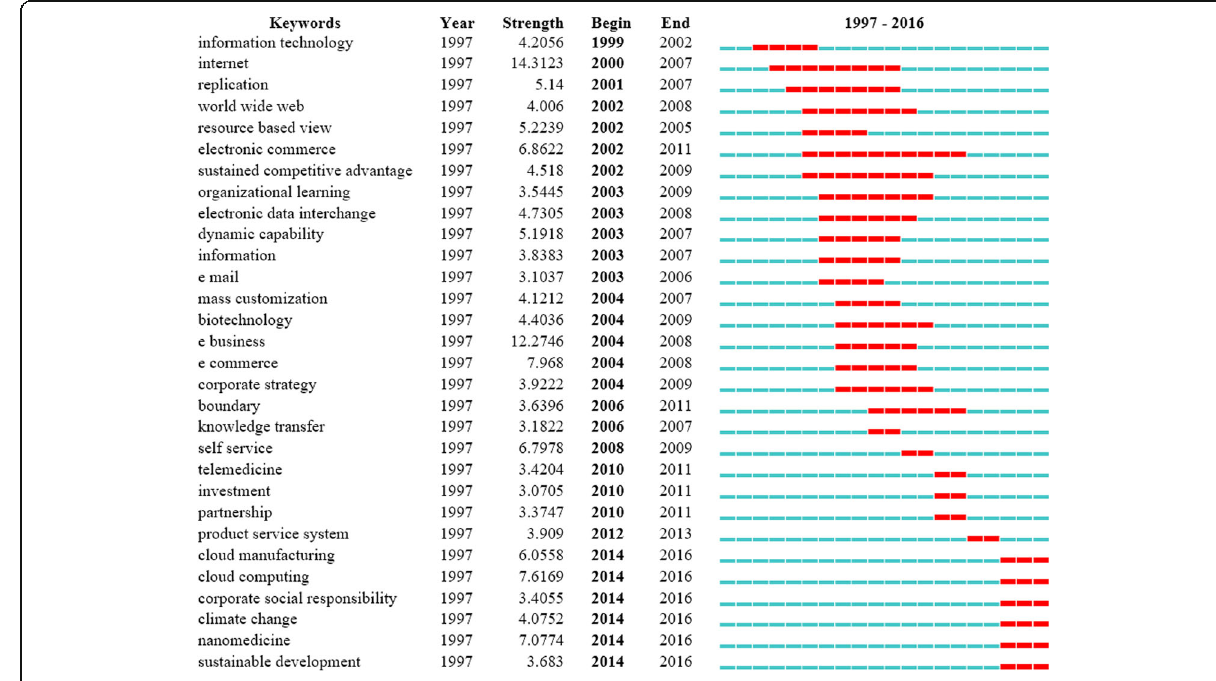
Fig. 6 Top 30 burst keywords on business model innovation in 1997 –